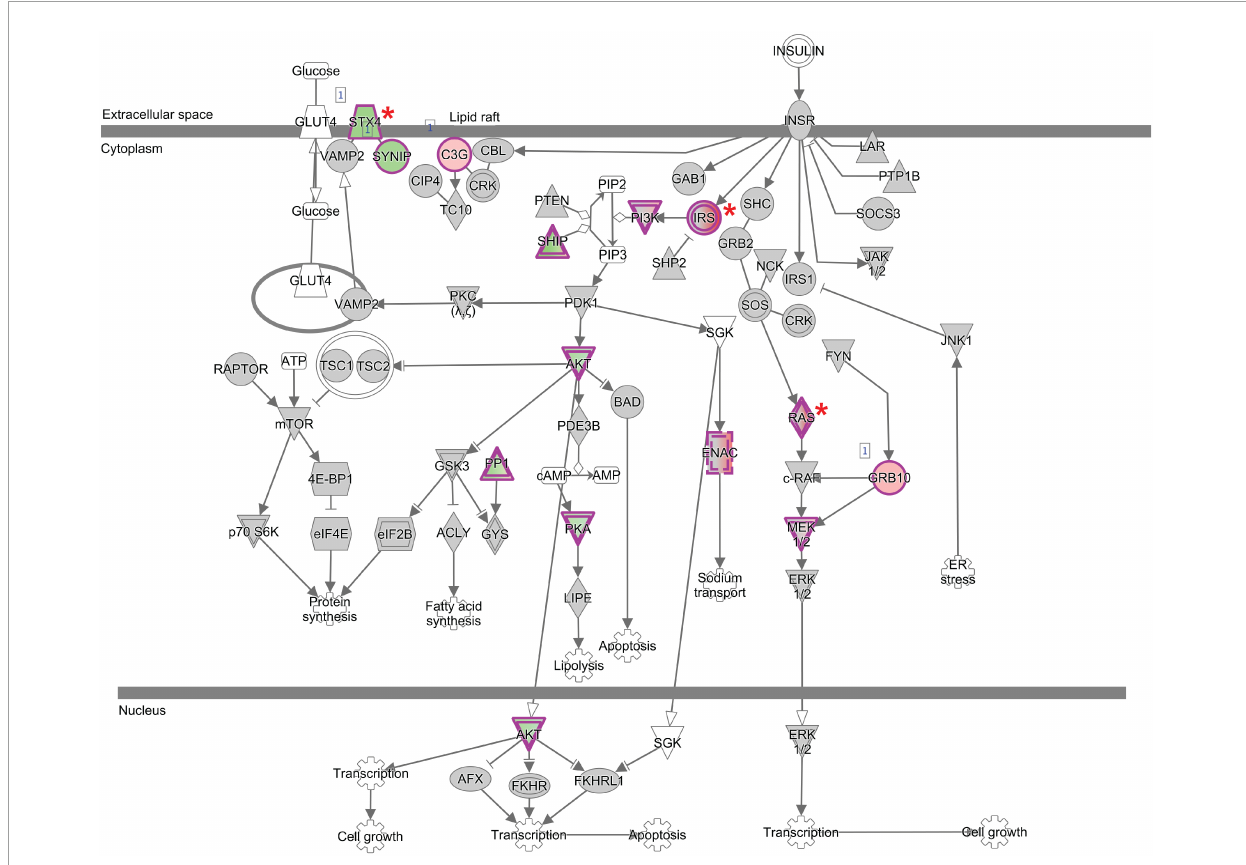
FIGURE7 Functional network analysis of the Insulin Receptor Signaling Pathways generated by IPA. Gene names are displayed by cellular localization (extracellular space, cytoplasm, or nucleus). Interactions between molecules are supported by information in the Ingenuity knowledge base. Genes shaded red are upregulated and genes shaded green are downregulated. Genes marked with asterisk have been validated. Solid line ending with (a) solid arrowhead indicates activation; (b) vertical line indicates inhibition; (c) solid arrowhead plus vertical line indicates inhibits and acts on; (d) open arrowhead indicates translocation; (e) open diamond head indicates enzyme catalysis. Node shapes represent functional classes: concentric circles; complex/group, vertically diamonds; enzyme, horizontally ellipses; transcriptional regulator, triangle; phosphatase, inverted triangles; kinase, hexagon; translational regulator, trapezoid; transporter, inverted trapezoid for miRNA, and circles;